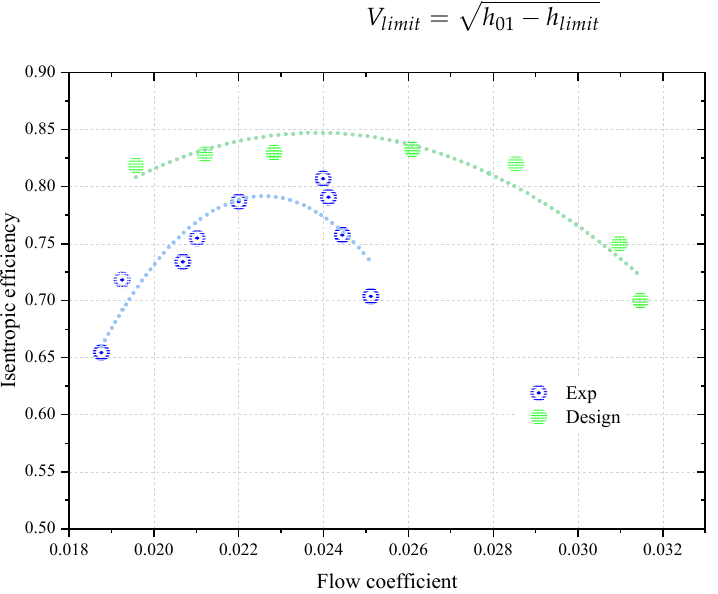
Figure 15. Comparison of dimensionless isentropic head coefficient performance curve.